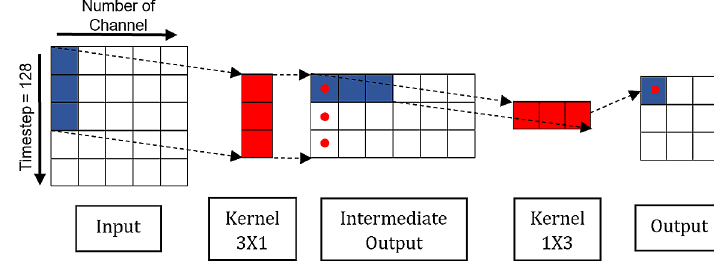
Figure 4. Separable